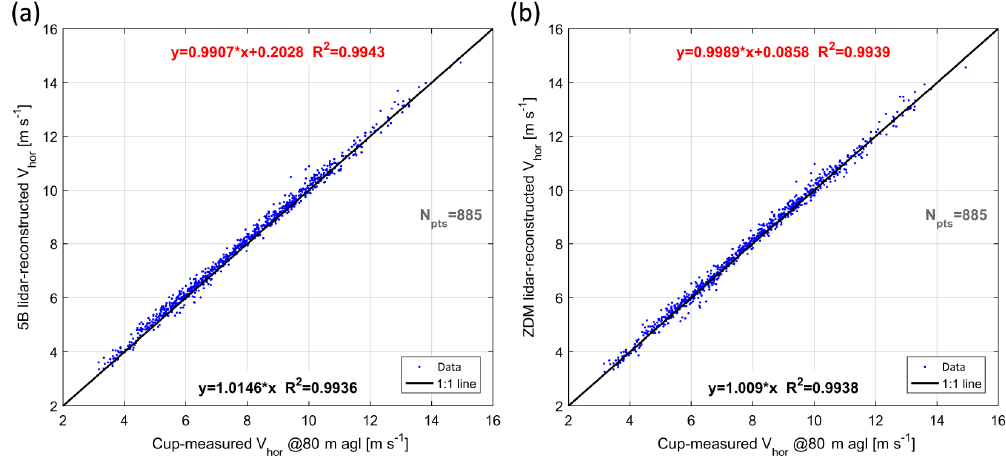
Figure 7. Comparison between mast-measured and lidar-estimated horizontal wind speed at 80m heighta.g.l. (a) 5B-Demo lidar, using five LOS, at 2 . 0 D rot . (b) ZDM lidar, using six LOS, at 2 . 5 D rot .